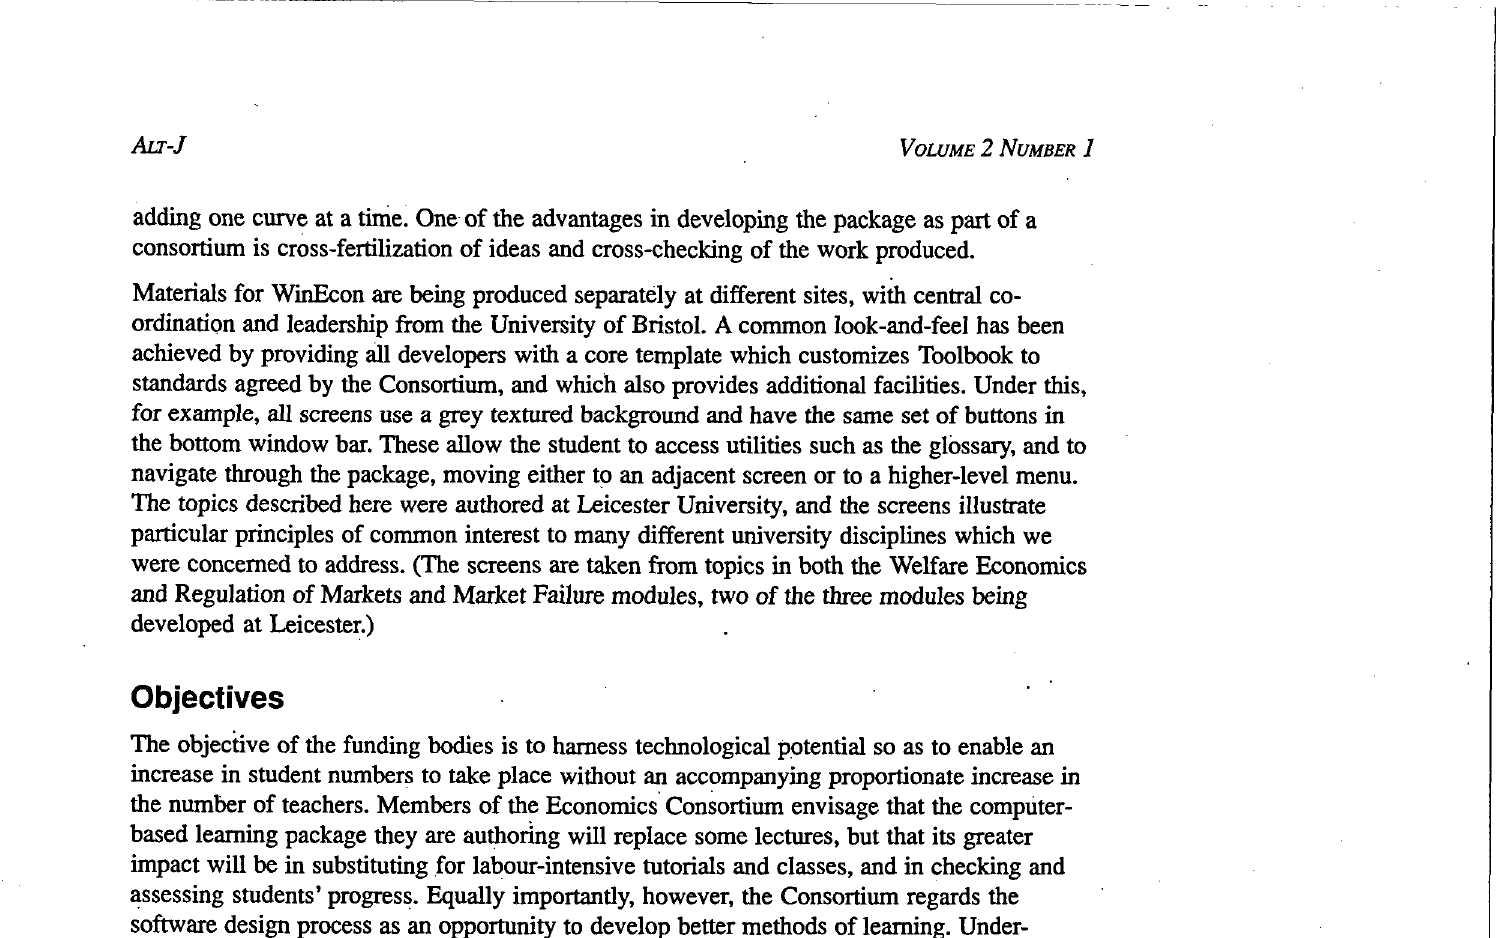
Figure 1: Presenting textual information